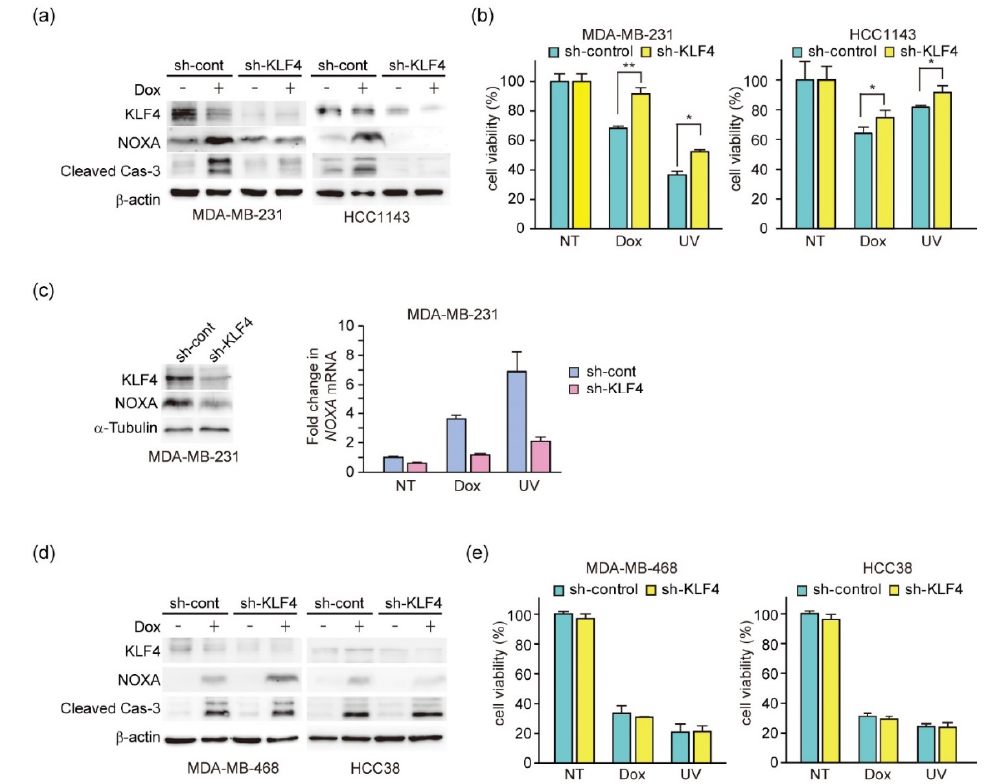
Figure 7. Anti-cancer drug-induced DNA damage elicits NOXA-dependent apoptosis enhanced by high expression of KLF4. ( a , b ) TNBC cell lines (MDA-MB-231 and HCC1143) that stably expressed shRNA-targeting KLF4 (sh-KLF4) or sh-control were treated with doxorubicin (1 μg/mL) or irradiated with UV light (100 J/m 2 ). After 24 h of treatment, 20 μg total cell lysates was subjected to immunoblot analysis with the indicated antibodies ( a ) and cell viability was measured by CCK-8 assays ( b ). Quantitative analysis of immunoblot results is shown in Supplementary Figure S5a. Error bars indicate S.E.M. ( n = 3). (* p < 0.05, ** p < 0.01, Welch’s t-test; n = 3). ( c ) MDA-MB-231 cells that stably expressed shRNA-targeting KLF4 (sh-KLF4) or sh-control were subjected to immunoblot analysis with the indicated antibodies (left). Cells were treated with doxorubicin (1 μg/mL) or irradiated with UV light (100 J/m 2 ). After 24 h, NOXA mRNA expression levels were measured by qPCR (right). Quantitative analysis of immunoblot results is shown in Supplementary Figure S5b. ( d , e ) TNBC cell lines (MDA-MB-468 and HCC38) that stably expressed shRNA-targeting KLF4 (sh-KLF4) or sh-control were treated with doxorubicin (1 μg/mL) or irradiated with UV light (100 J/m 2 ). After 24 h of treatment, 20 μg total cell lysates were subjected to immunoblot analysis with the indicated antibodies ( d ) and cell viability was measured by CCK-8 assays ( e ). Quantitative analysis of immunoblot results is shown in Supplementary Figure